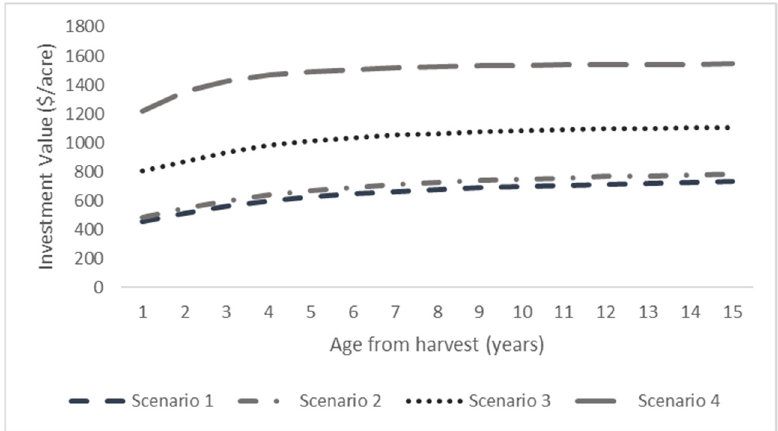
Figure 2. Option values for flexibility of delaying harvest by 15 years.